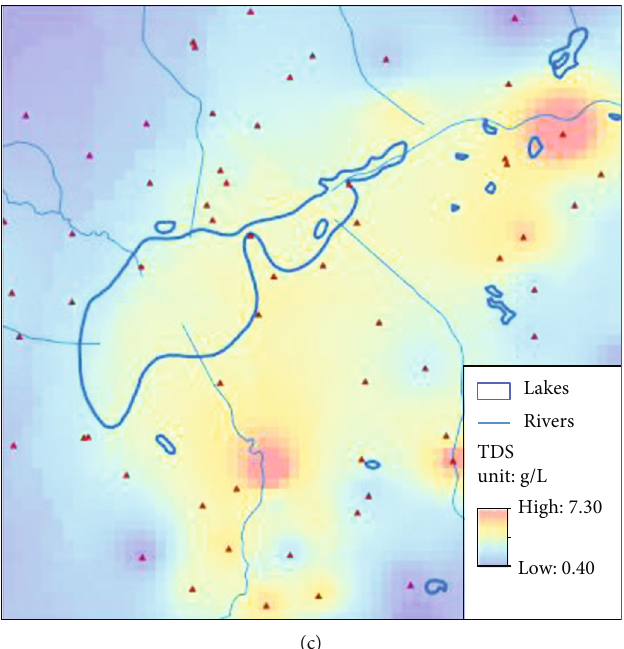
Figure 3: Vegetation-groundwater characteristics in the study area: (a) fractional vegetation coverage; (b) groundwater depth; (c) groundwater TDS.